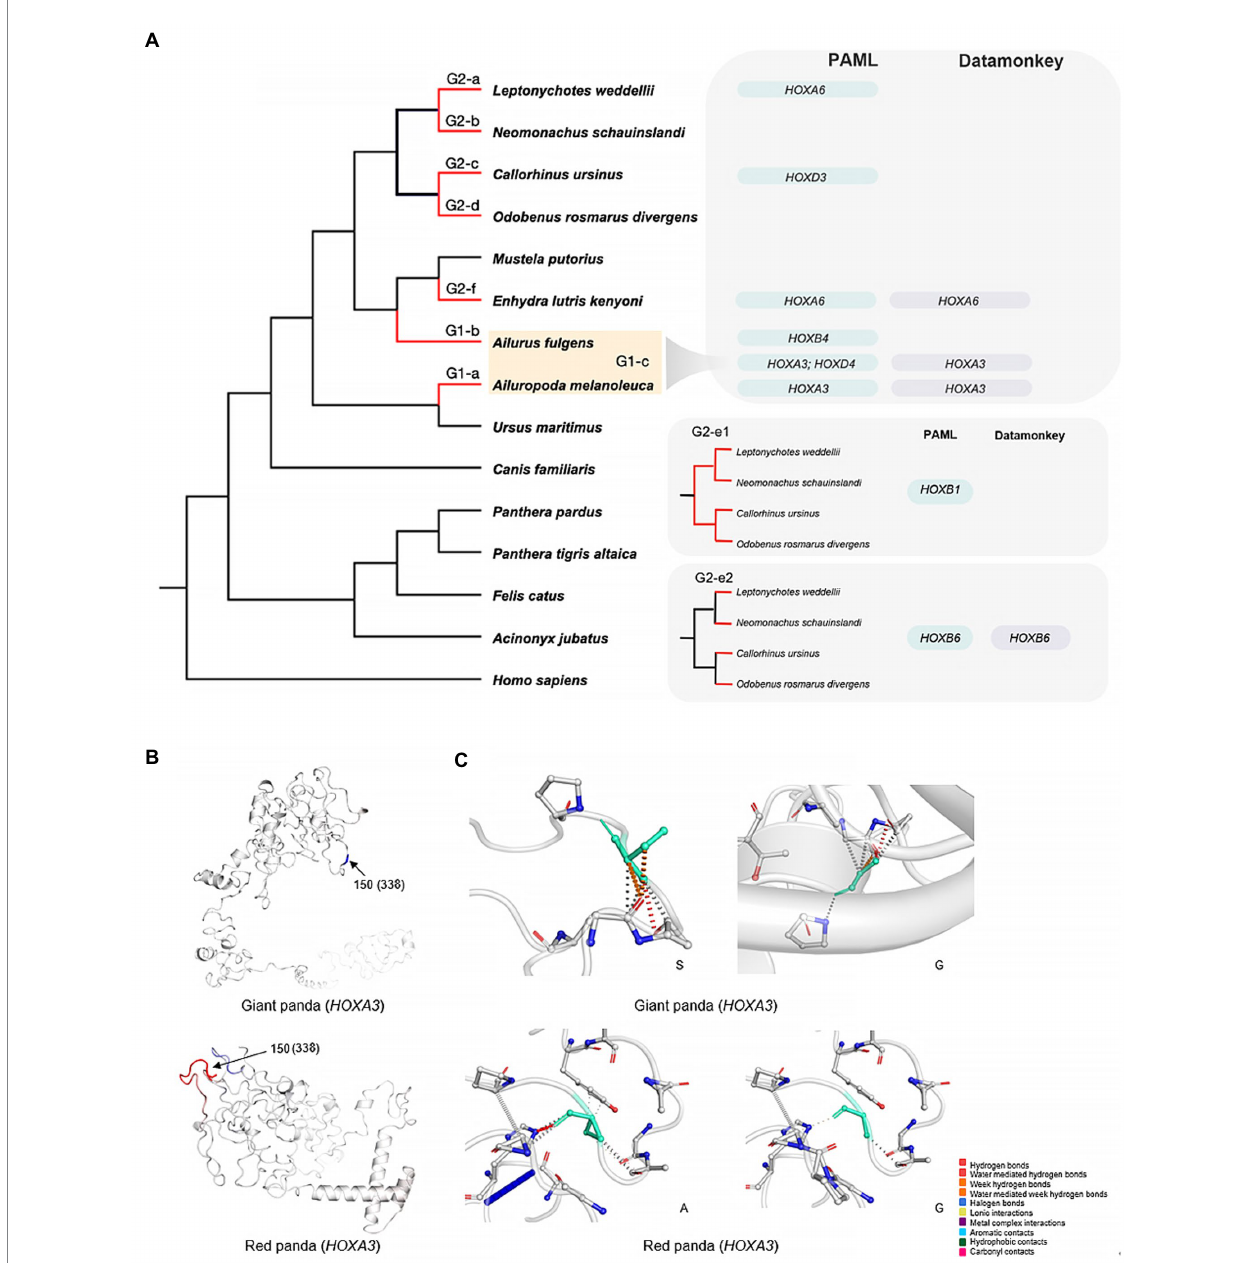
FIGURE 3 Positively selected genes in 15 species. (A) The red lines (left) represent the foreground branches used in this analysis. Two categories with different foreground branch setting are shown. (B) The 3D structures of HOXA3 for the giant panda and red panda built using a deep-learning-based method, trRosetta. The amino acids are colored according to the vibrational entropy change upon mutation. Blue represents rigidification of the structure, and red represents a gain in flexibility. 150 (338), 150 represents the 150th codon when performing the PAML analysis, and 338 indicates the 338th amino acid using the human gene sequence as the reference (C) The results of interatomic interaction prediction. Wild-type and mutant residues are colored light green and are also represented as sticks alongside the surrounding residues that are involved in any type of